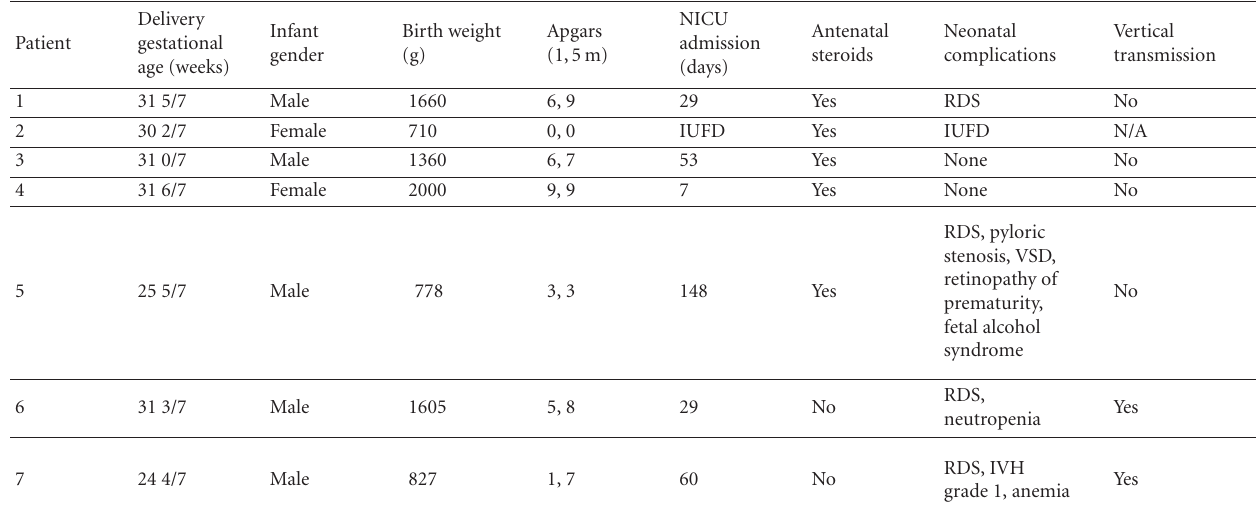
Table 4: Infant sequelae and complications. N/A: not assessable, secondary to intrauterine fetal death. NICU: neonatal intensive care unit; RDS: respiratory distress syndrome; IVH: intraventricular hemorrhage; NEC: necrotizing enterocolitis; IUFD: intrauterine fetal demise; VSD: ventriculoseptal